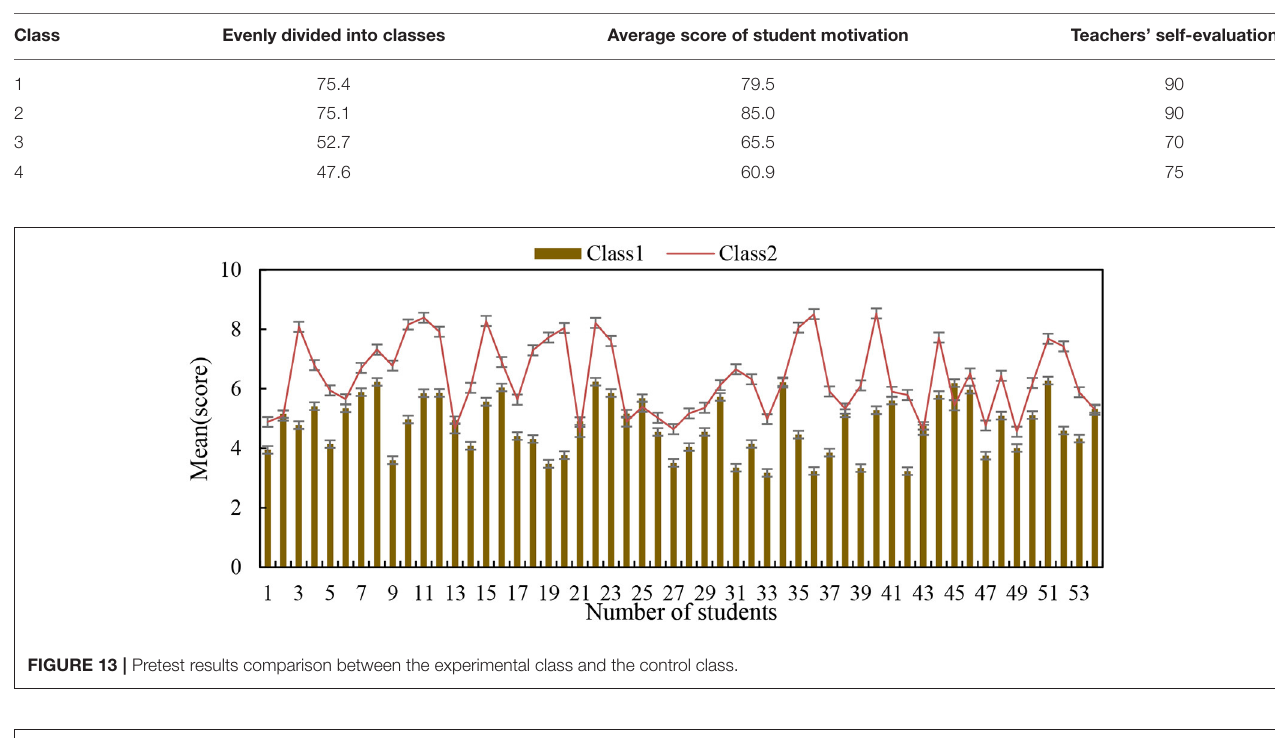
TABLE 10 | Survey results.